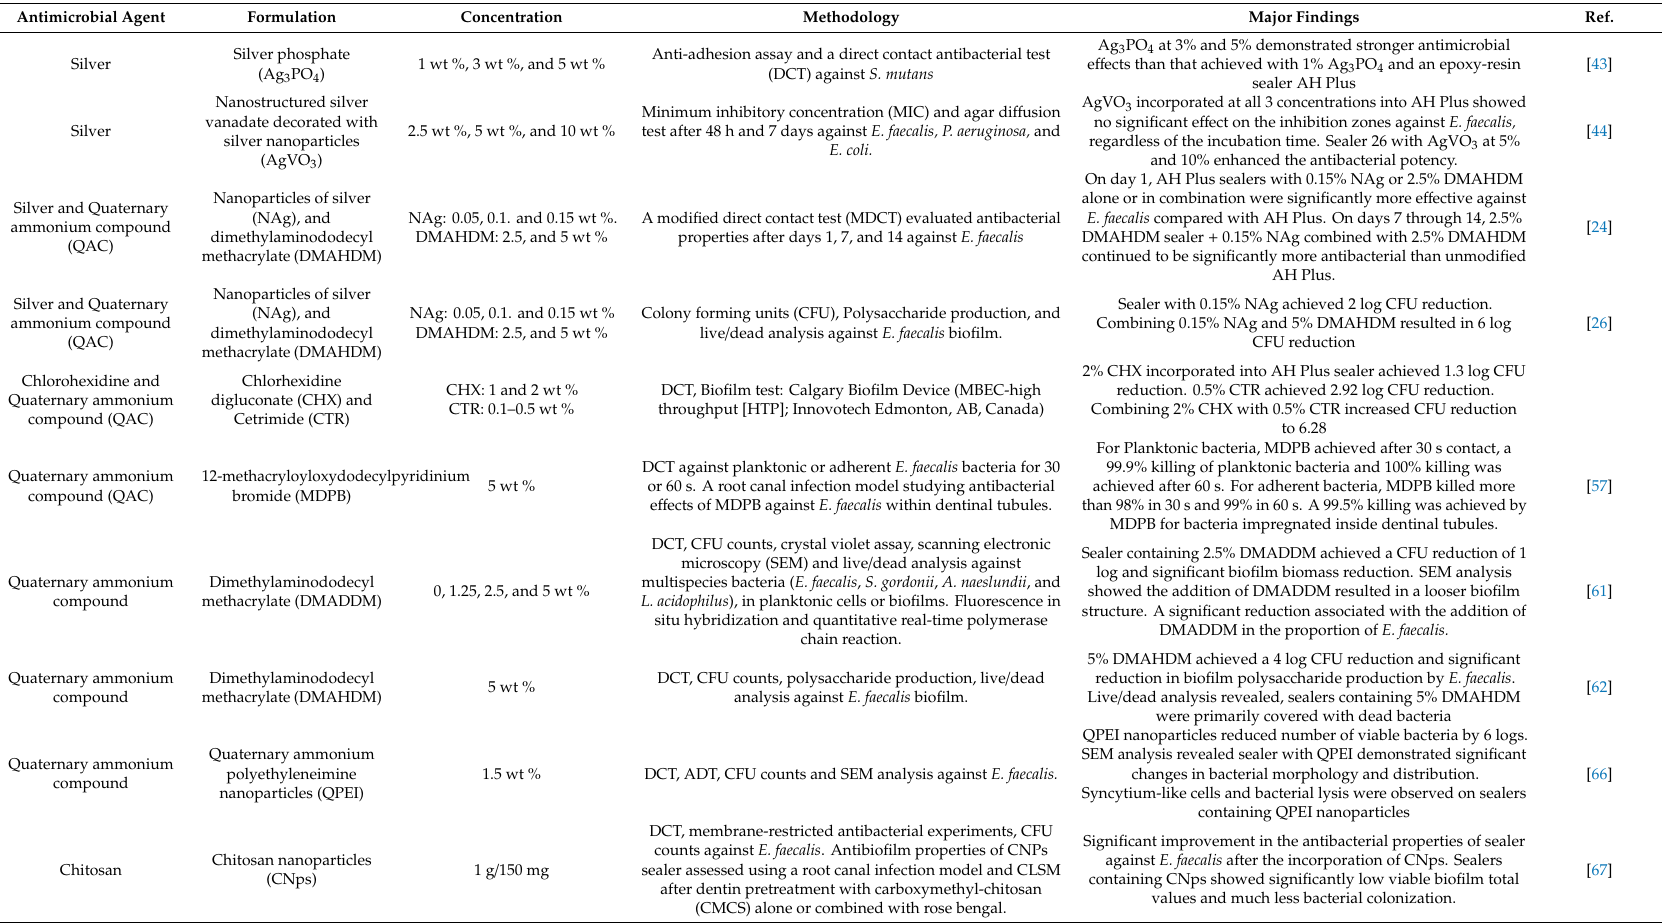
Table 1. A summary of antimicrobial additives that have been incorporated into root canal